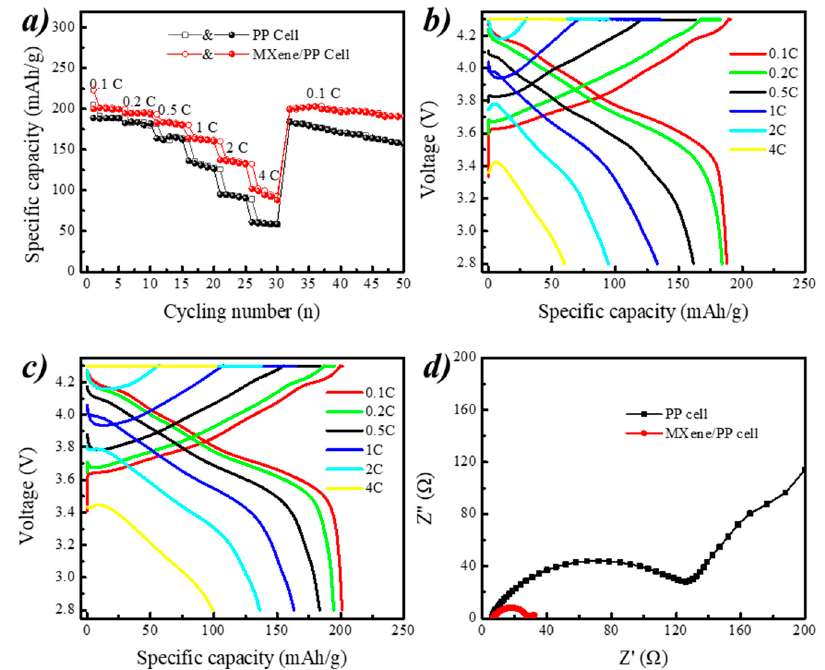
Figure 7. ( a – c ) Rate performances and ( d ) electrochemical impedance spectroscopy (EIS) spectra of PP and MXene/PP cells.